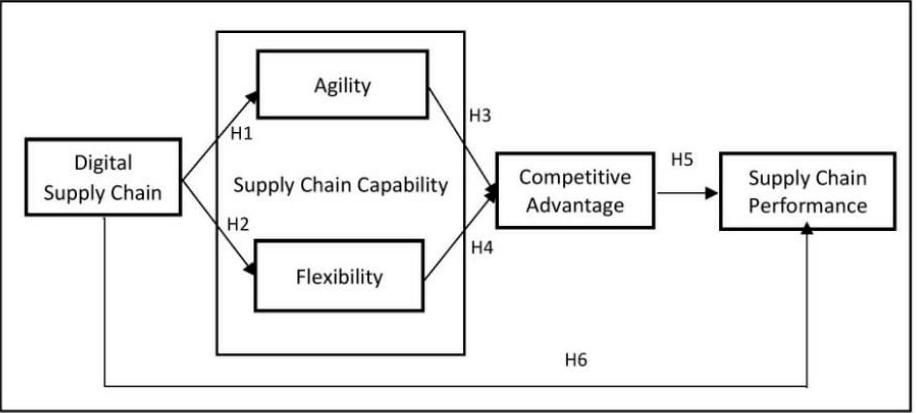
Figure 1. Theoretical framework of digital technology for supply chain performance.